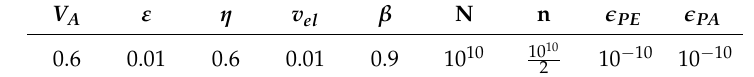
Finite-size, N=10 8 Finite-size, N=10 10 Finite-size, N=10 12 Finite-size, N=10 14 Asymptotic